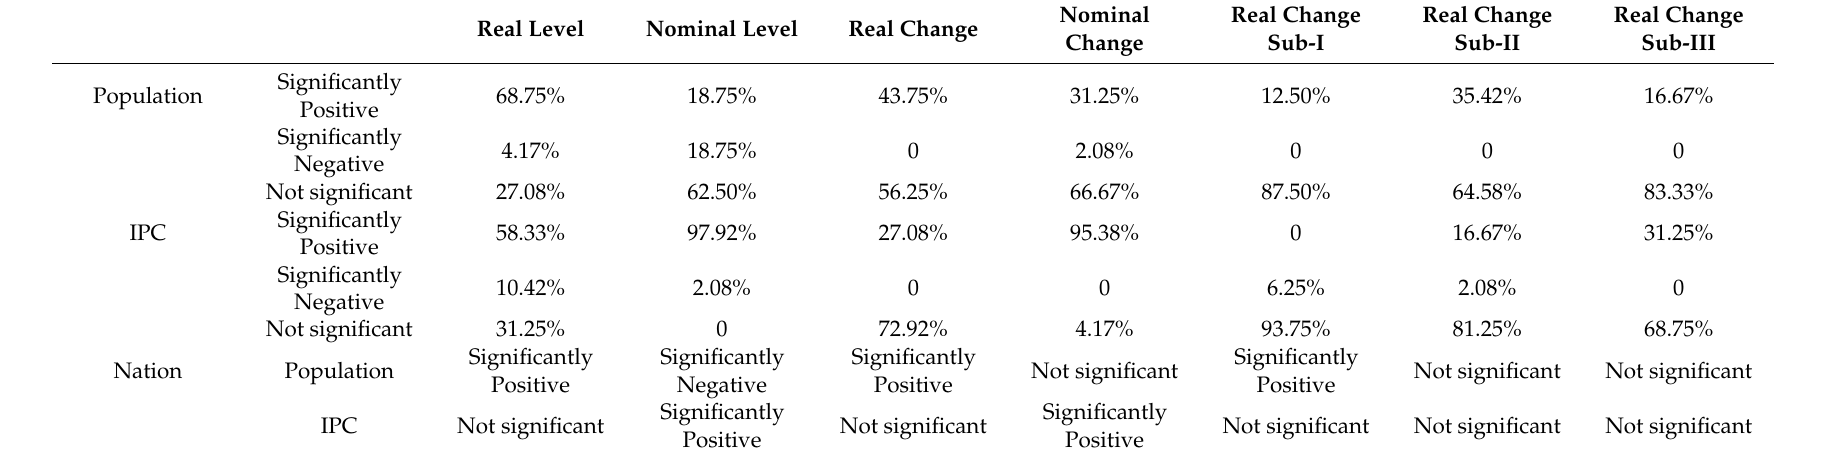
Table 1. Comparison of nominal and real term variables’ regression